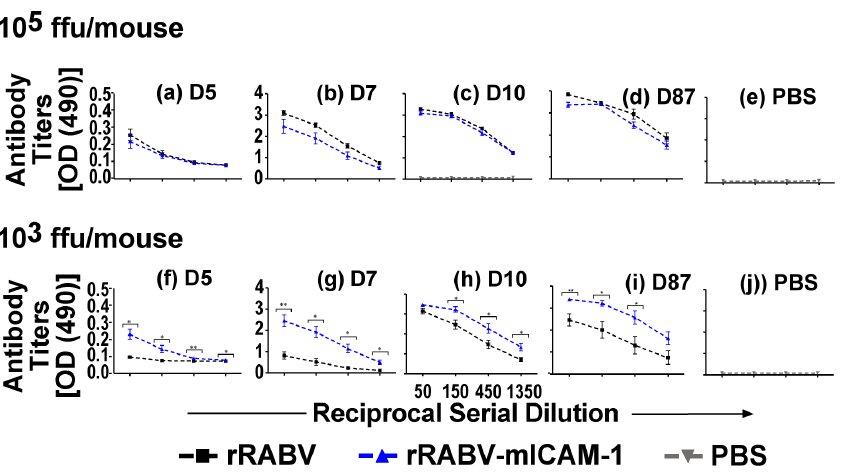
Figure 5. 100-fold less rRABV-mICAM-1 is needed to induce comparable immunity in mice compared to mice immunized with 10 5 ffu/mouse. C57BL/6 mice were immunized i.m. with 10 5 (A) or 10 5 (B) ffu/mouse of rRABV and blood collected at the indicated time points. Four serial three-fold dilutions of sera were analyzed by ELISA to determine anti-RABV G antibody titers and presented as OD 490 of the reciprocal serial dilution. For comparison, sera from PBS-immunized mice (panels e and j) were tested in parallel. Statistical difference in antibody titers by ELISA between two groups of data was determined using an unpaired, two-tailed t test and data is presented at the mean 6 SEM. *p , 0.05, **p=0.01 2 0.001, ***p # 0.001. (N=5 mice per group). (ffu=focus forming units; OD=optical density)